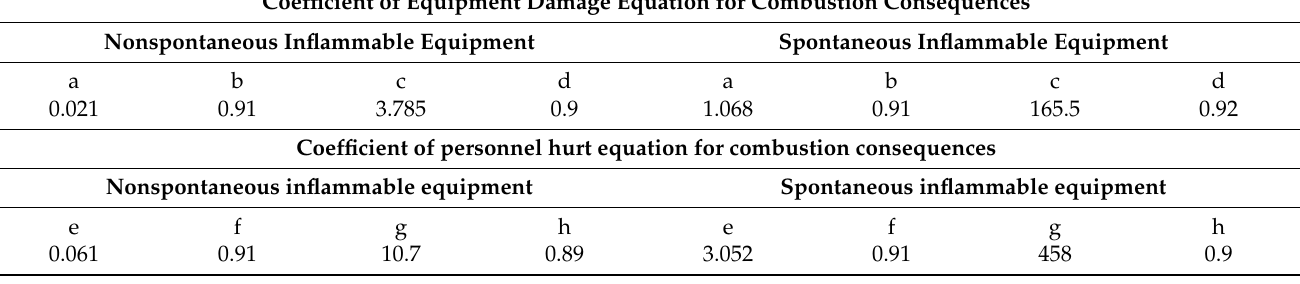
Table 4. Failure Consequence Equation